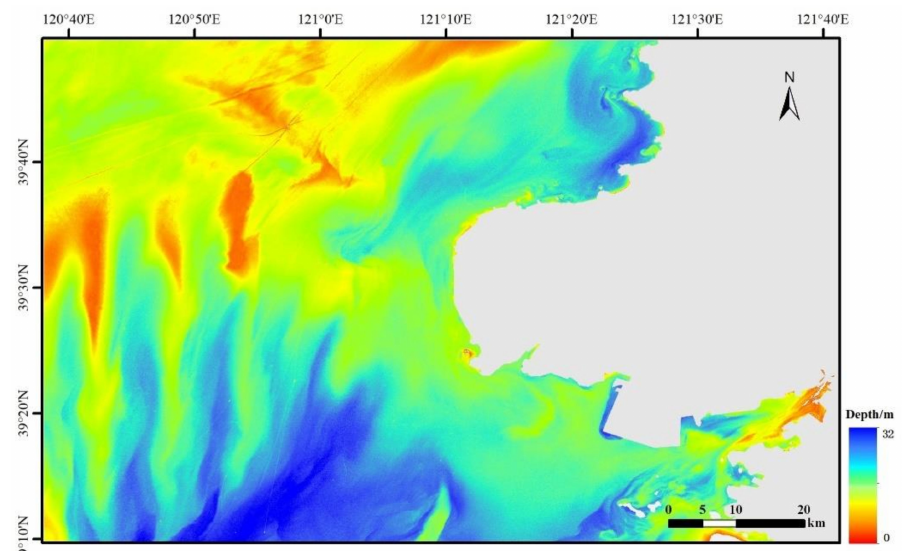
Figure 13. Water depth inversion